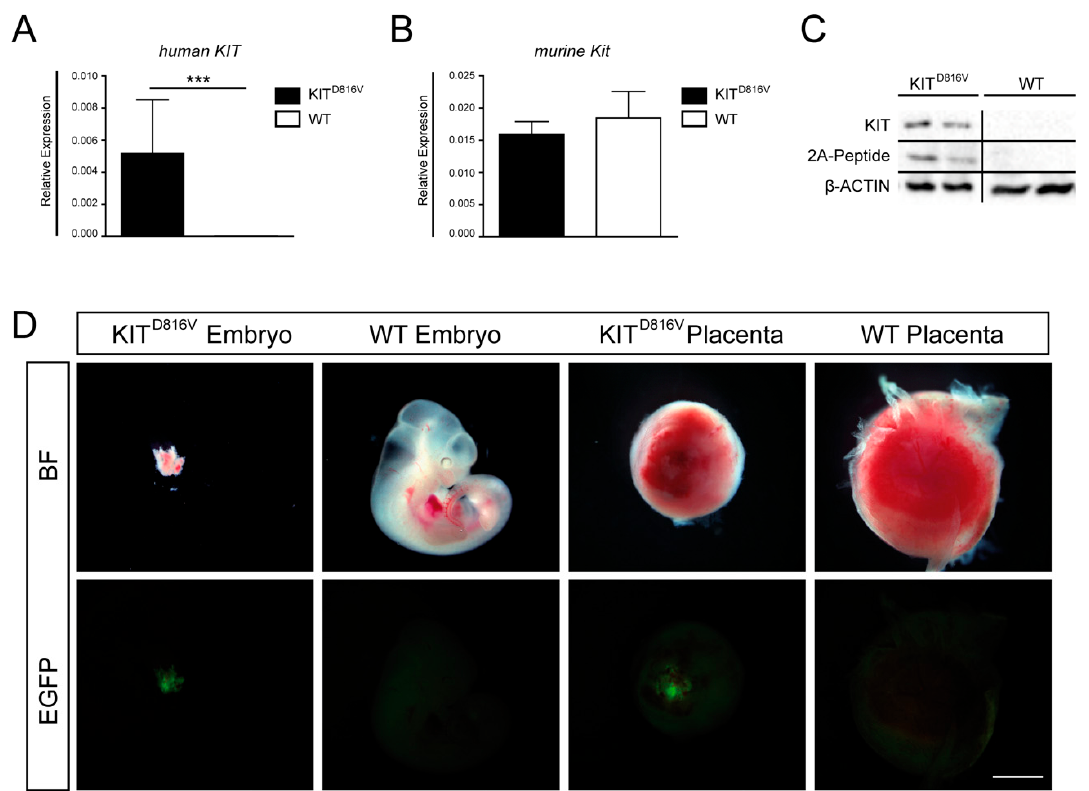
Figure 1. Detection of KIT D816V -positive embryos and placentas: ( A ) qRT-PCR for transgene expression of human KIT in KIT D816V and wildtype (WT) placentas obtained on E10.5 and ( B ) qRT-PCR for endogenous expression of murine Kit in KIT D816V and WT placentas obtained on E10.5. RNA was obtained from at least three biological repeats. Expression is normalized to the housekeeping gene Gapdh . Bars display mean value ± SD. Significance was determined by unpaired t-test and indicated with *** p < 0.001. ( C ) Western Blot detecting KIT and 2A-peptide in placentas at E11.5 in comparison to β -ACTIN and ( D ) photographs showing KIT D816V and WT expressing embryos and placentas at E11.5 in brightfield (BF) and GFP fluorescence (scale bar: 1 mm): Experiments were performed in at least tree biological repeats.